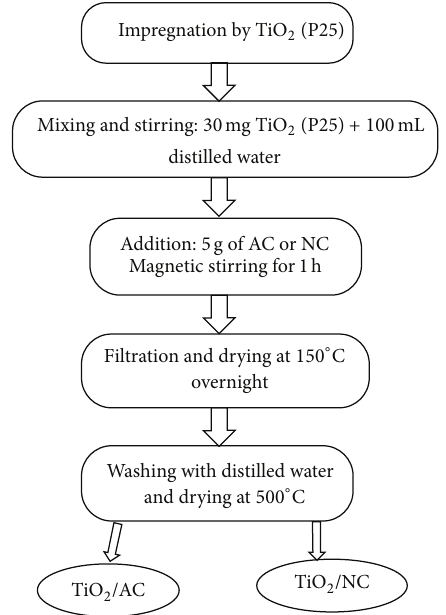
Figure 1: Scheme of the preparation method of photocatalysts by the impregnation